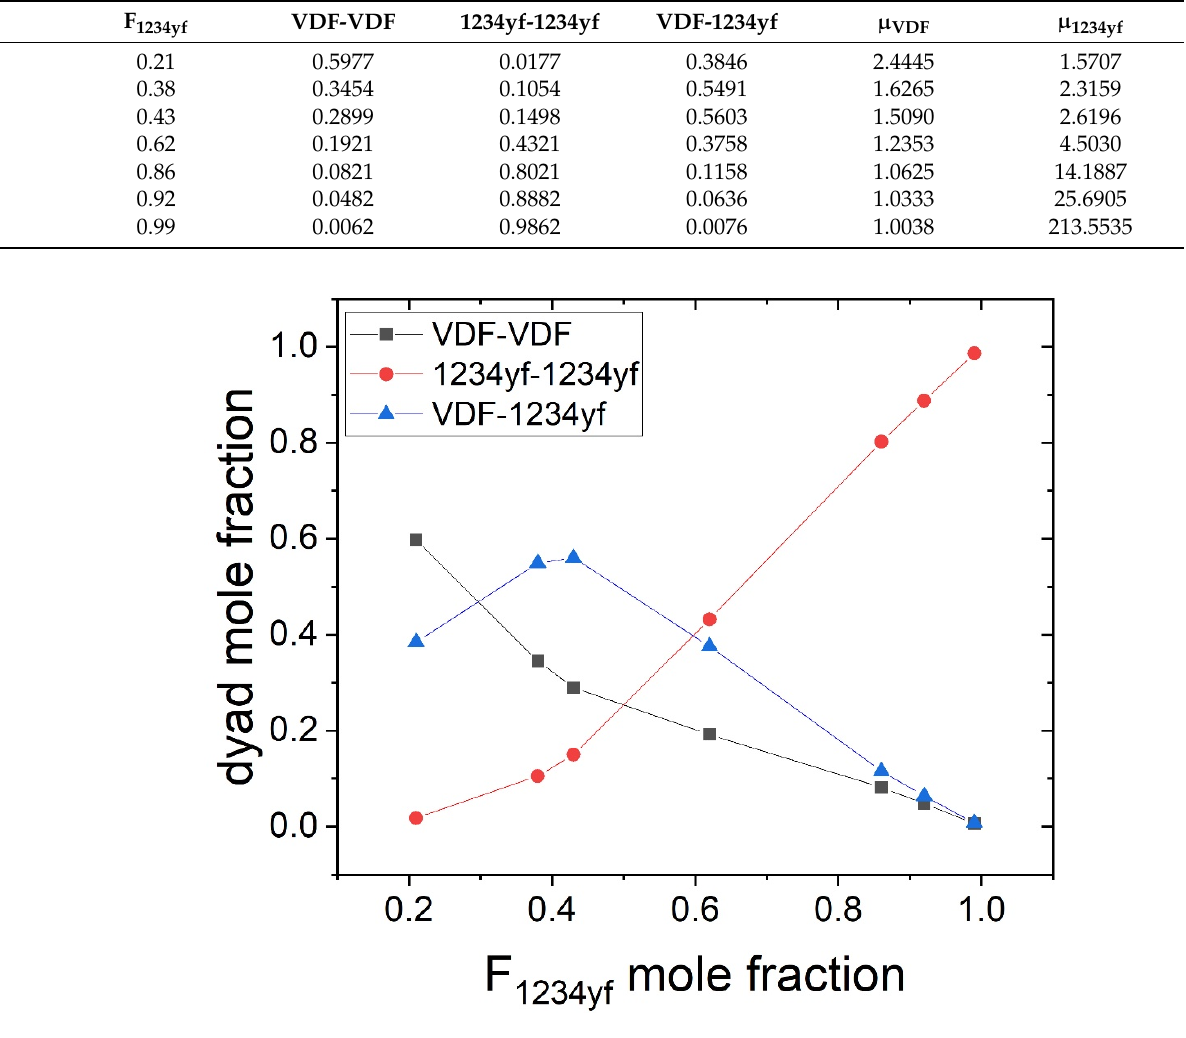
Figure 6. Dyad monomer sequence fractions versus the 1234yf mole fraction for the P(VDF- co - 1234yf) copolymers.